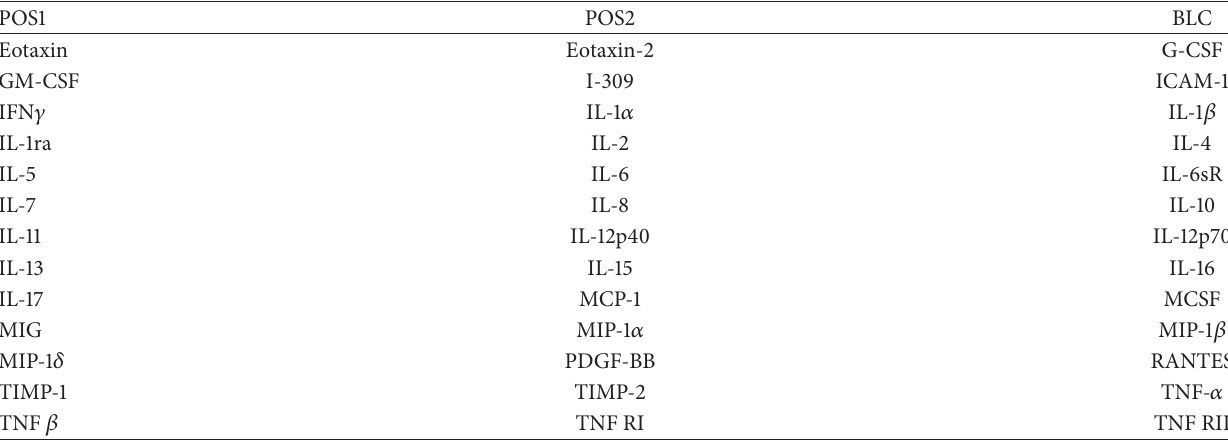
Table 4: Forty inflammatory markers measured by Quantibody Human Inflammation